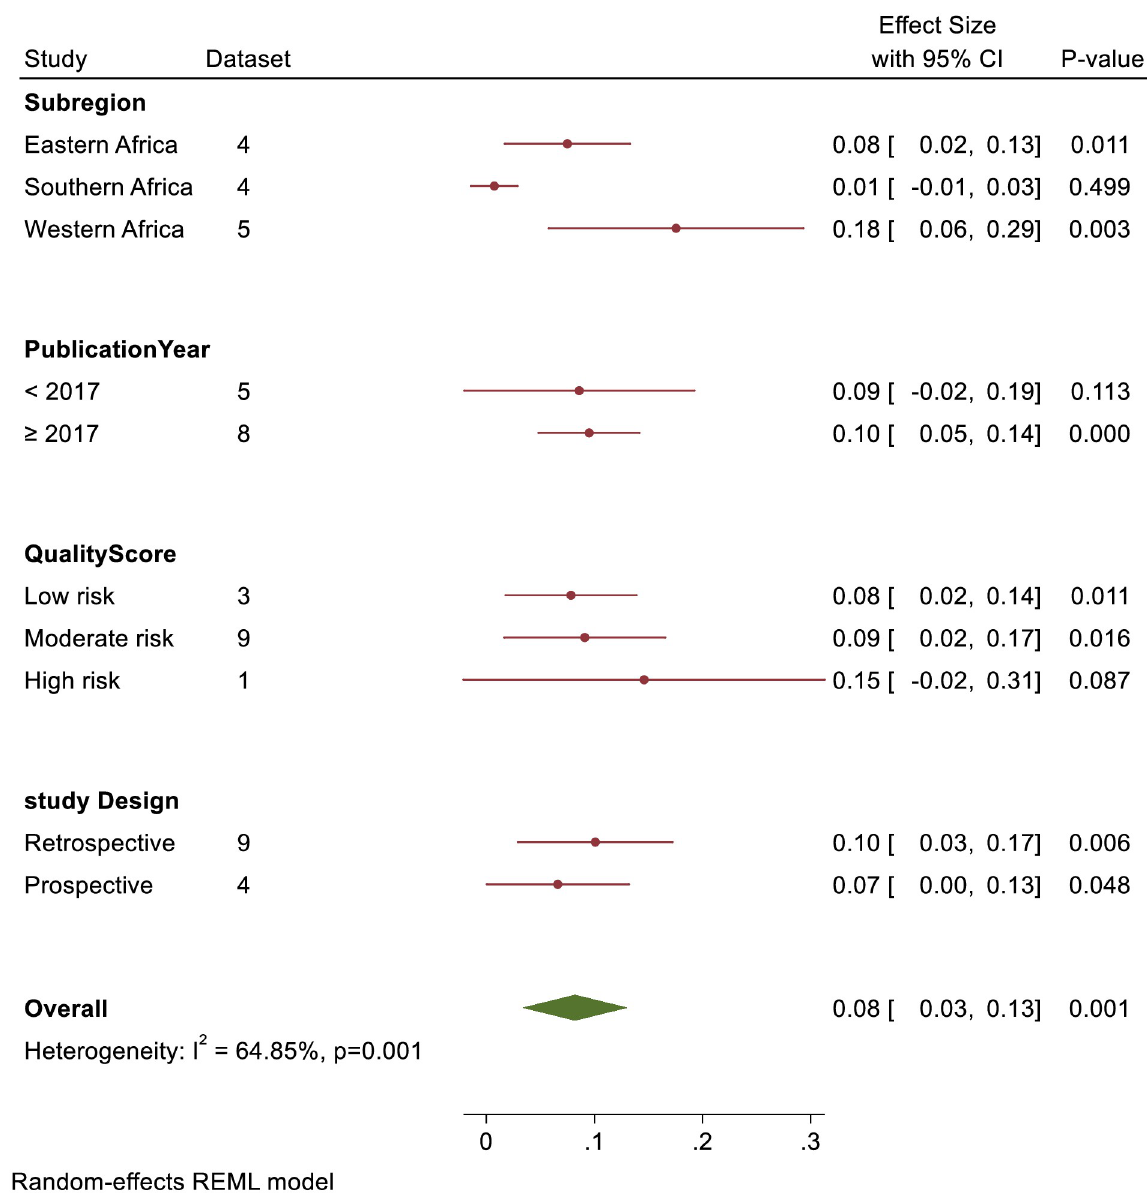
Fig 3. Forest plot of sub-group analysis of TBI case fatality rate in Sub-Saharan Africa.